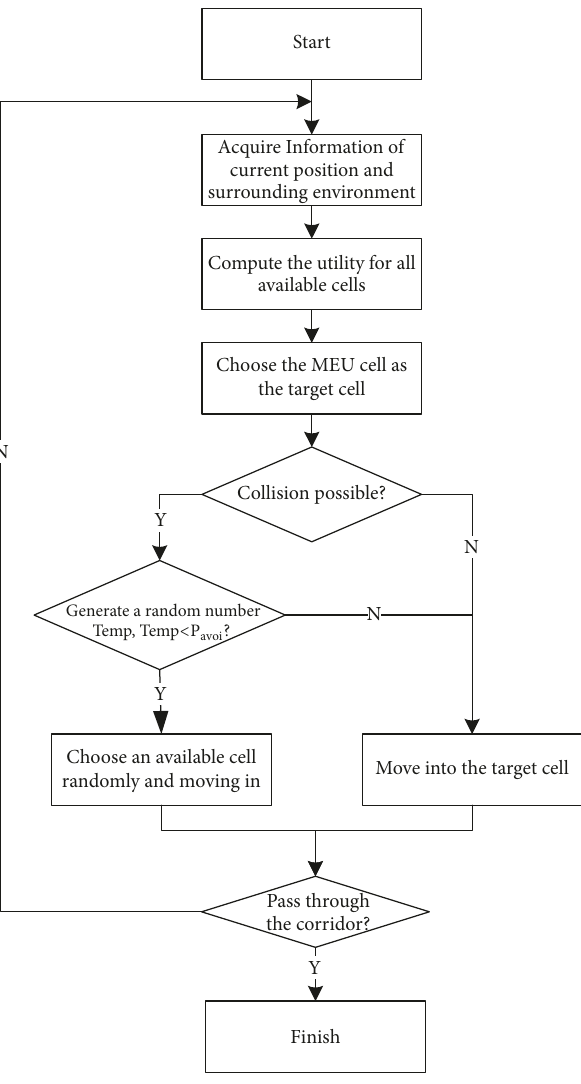
Figure 6: Pedestrian decision-making flow chart.